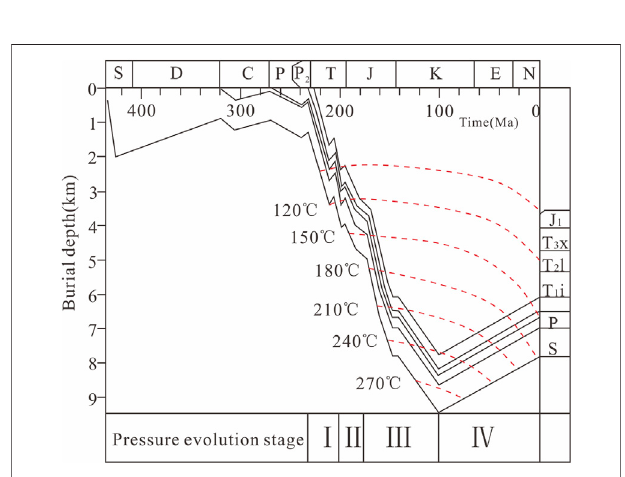
FIGURE 13 | Burial history of well YB102 (modi fi ed after Zhang,2010)